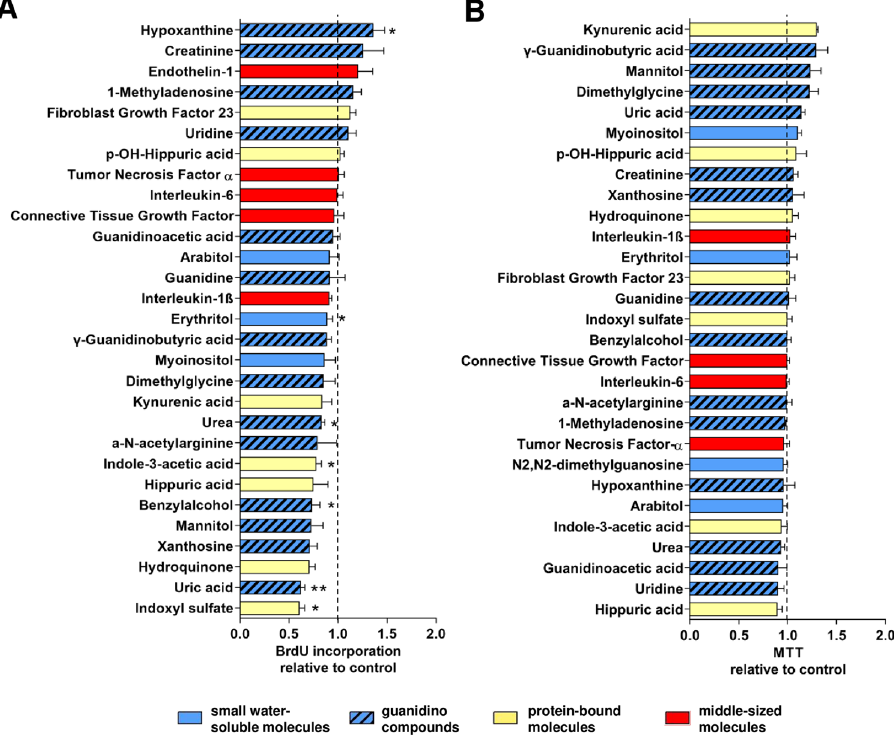
Figure 7. Screening of individual URS for proliferation and toxicity. ( A ) BrdU incorporation and ( B ) metabolism of MTT were measured after exposure of MSC to URS at the highest reported uremic concentrations for 24 h. Results are expressed relative to the appropriate solvent control (set to 1.00). Means + SEM, n ≤ 14, * P < 0.05, ** P <